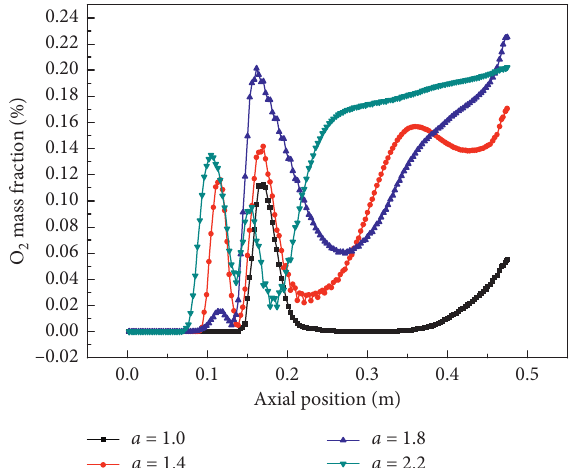
Figure 13: O 2 concentration distribution along the longitudinal centerline of the burner under different excess air